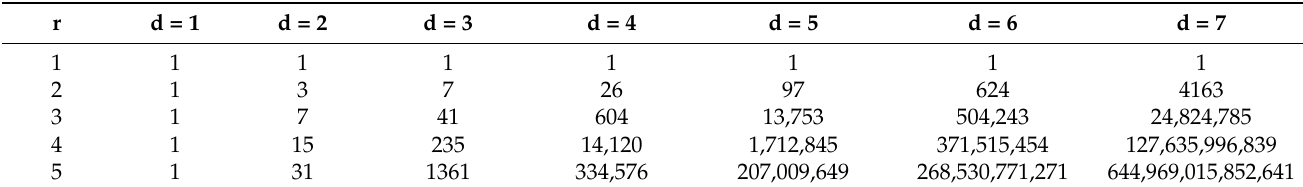
Table 1. The number Isoc ( X ; d ) for small values of first Betti number r (alias the number of generators of the free group F r ) and index d . Thus, the columns correspond to the number of conjugacy classes of subgroups of index d in the free group of rank r